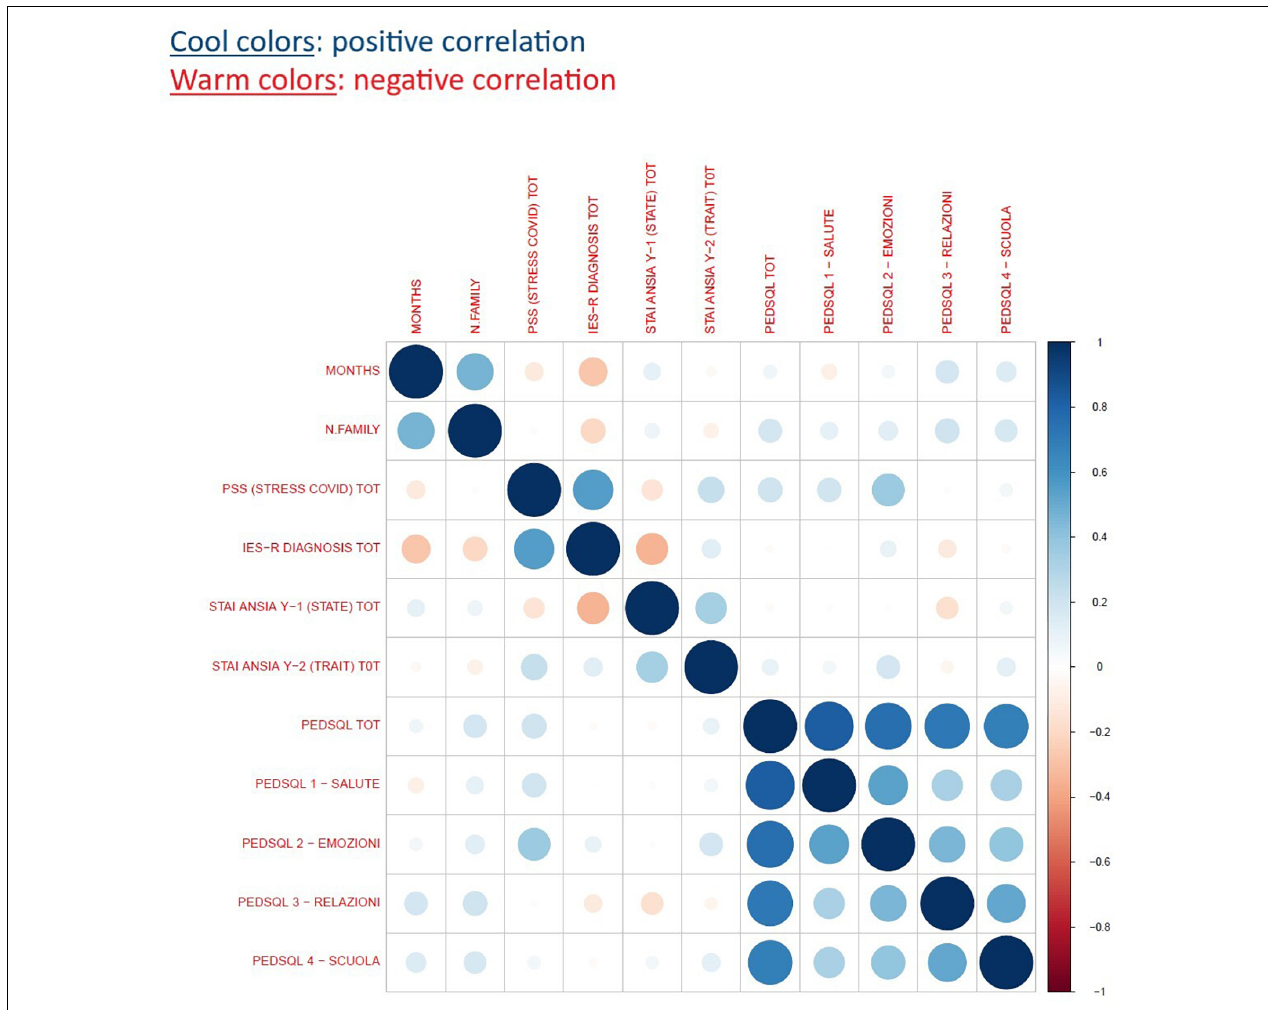
FIGURE 1 | Cross correlation